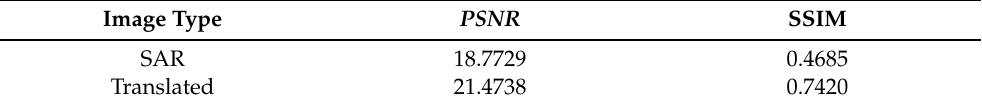
Figure 5. Examples of translation. Columns ( a – l ) show the results of different categories, respectively, among which ( a – c ) belong to Quest Kodiak 100 Series II, ( d – f ) Cessna 208B, ( g , h ) Ka-32, and ( j – l ) AS350. The first row shows optical images, then SAR images in HH, SAR images in HV, and SAR images in VV, each followed by corresponding translated images. Table 1. PSNR and SSIM of different